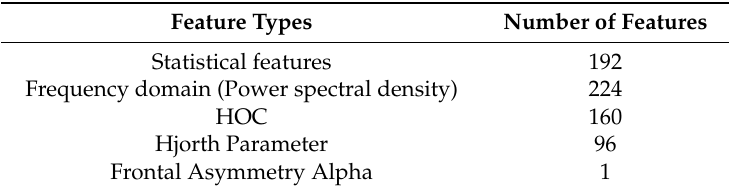
Table 2. Number of features from each type using the EEG